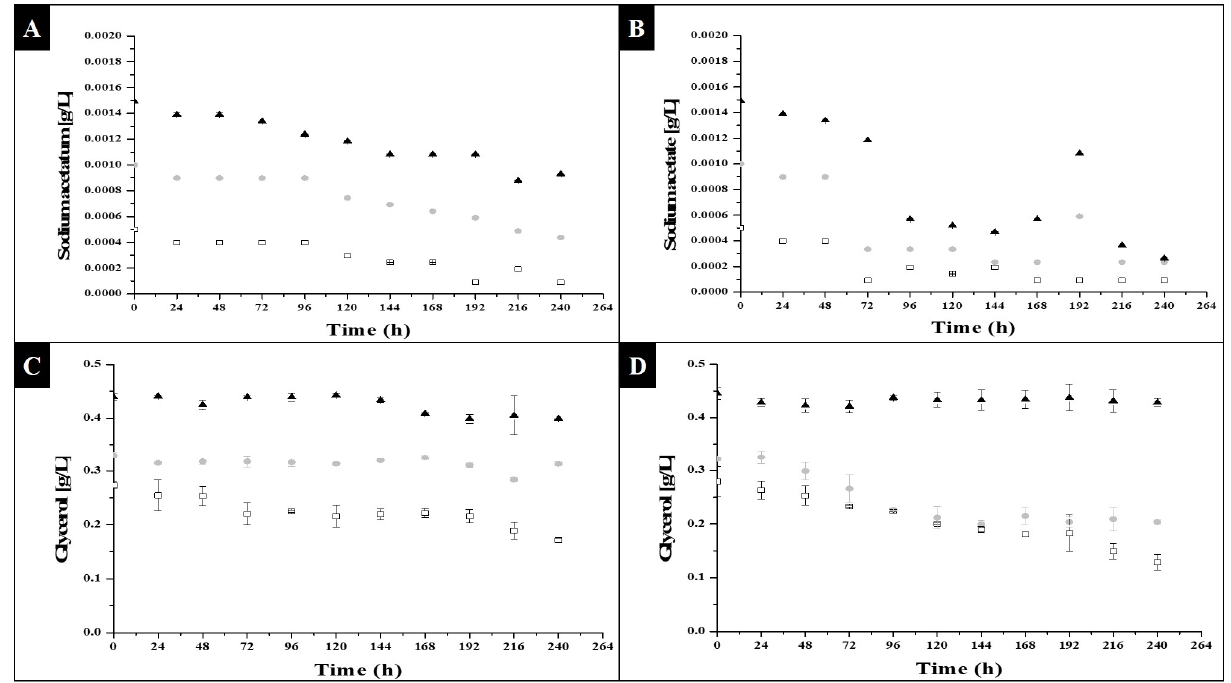
Figure 3. Substrate consumption of C. vulgaris under photoheterotrophic growth: ( A ) sodium acetate in 8 light hours and 16 darkness photoperiods; ( B ) sodium acetate in 16 light hours and 8 darkness photoperiods. (cid:3) 0.0005 g/L, • 0.001 g/L and (cid:78) 0.0015 g/L sodium acetate concentration; ( C ) glycerol in 8 light hours and 16 darkness photoperiods; ( D ) glycerol in 16 light hours and 8 darkness photoperiods. (cid:3) 0.27 g/L, • 0.33 g/L and (cid:78) 0.44 g/L glycerol